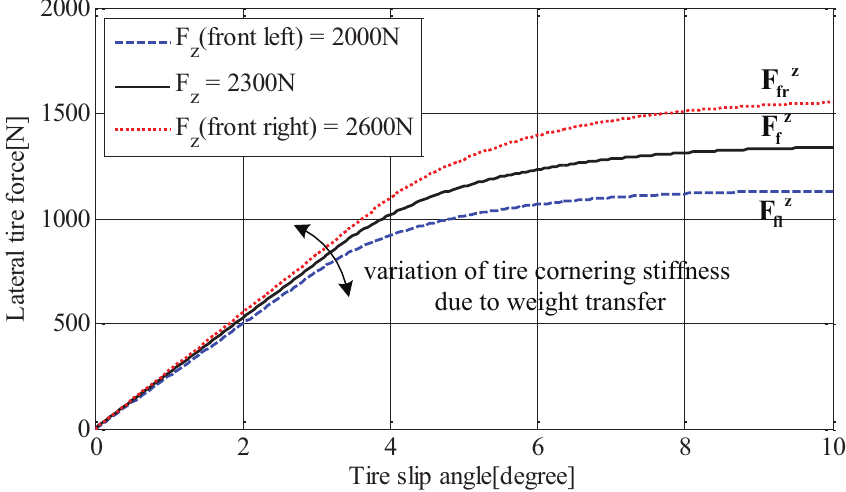
Figure 7. Characteristic curve between tire slip angle and lateral tire force with respect to load